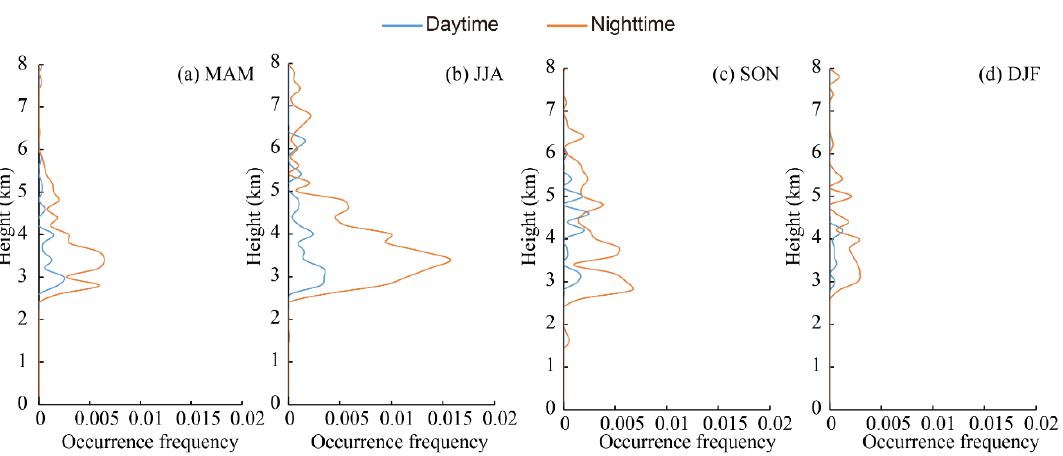
Figure 9. Vertical distribution of occurrence frequencies of elevated smoke layer in the daytime and nighttime in the Aral Sea region from CALIPSO observations for four seasons. 3.4. Seasonal and Diurnal Variations of Thickness of the Aerosol Subtype Layers in the Aral Sea